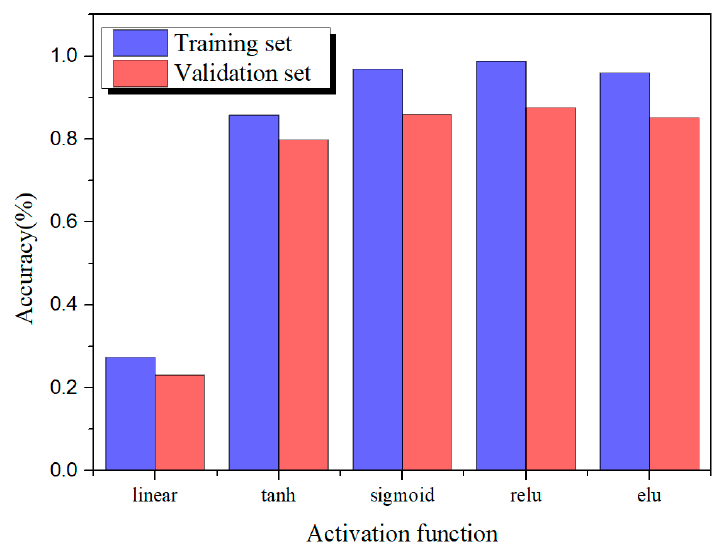
Figure 9. Comparison results of CNN on training set and validation set under different activation functions.